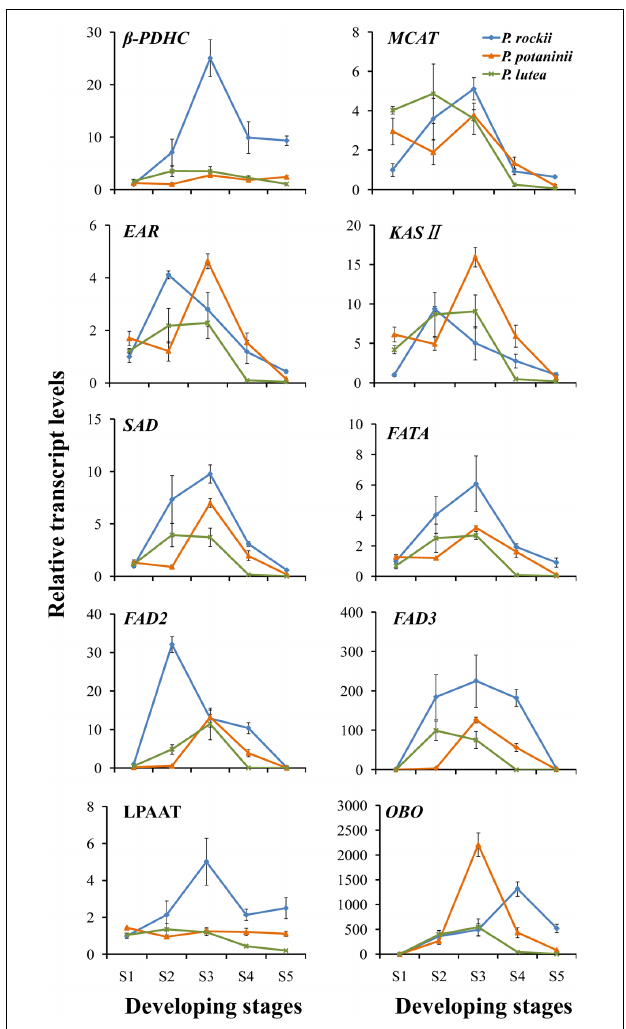
FIGURE 5 | Quantitative real-time polymerase chain reaction analysis of genes involved in seed oil synthesis in three wild species at different developmental stages. Relative expression values, normalized to 26S-18S ITS gene, were shown as 2 − (cid:49)(cid:49) C t relative to 20 DAP of P. rockii . Error bars represent the SD of three biological replicates with three technical replicates